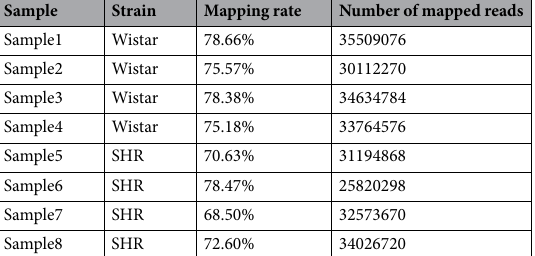
Table 1. Read mapping rates via Salmon’s quasi-mapping function. Mapping rate indicates the percentage of assigned reads relative to the total number of reads. The numerical value for mapped reads per sample are also shown.